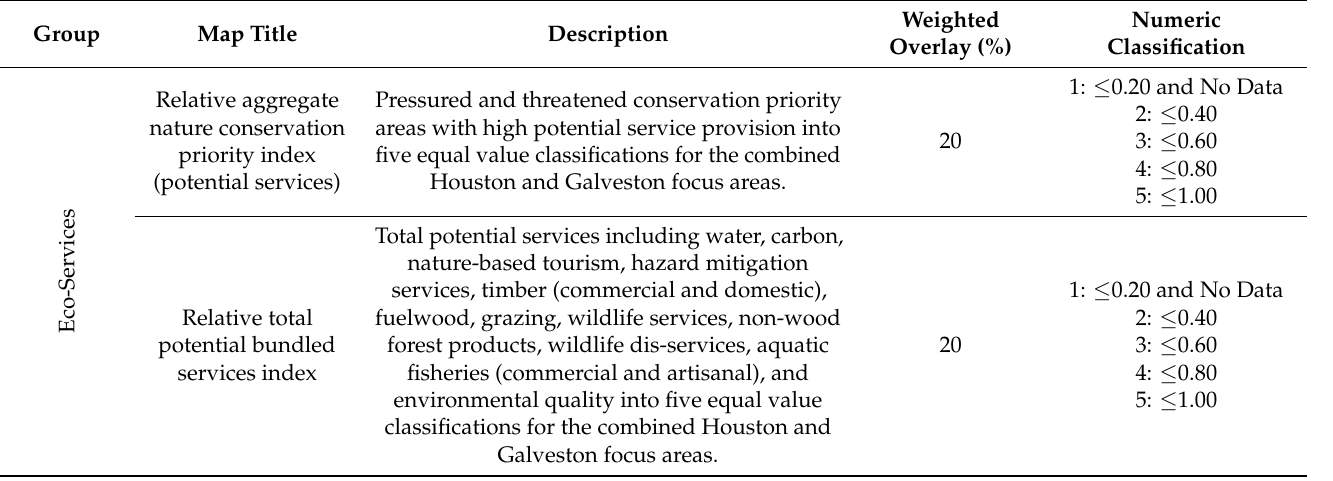
Figure 2. Exploded axon showing suitability model using Co$ting Nature outputs used to determine coastal areas with low nature-based solutions and high flood risk. Table 2. The breakdown of numeric classification for the eco-services and hazard mitigation groups’ maps as well as the descriptions given by Co$ting Nature used for the suitability